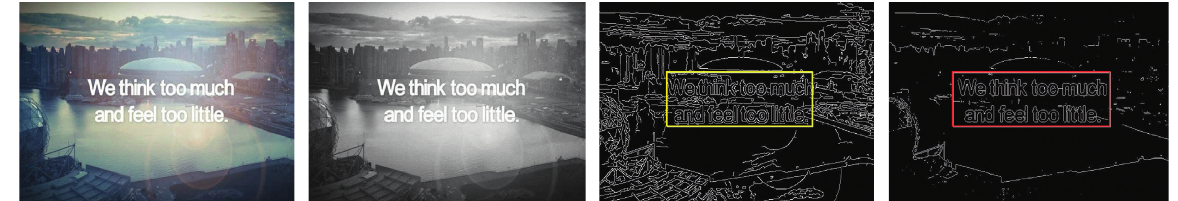
Figure 5: An example of textual translation character detection in the Char 74k dataset.